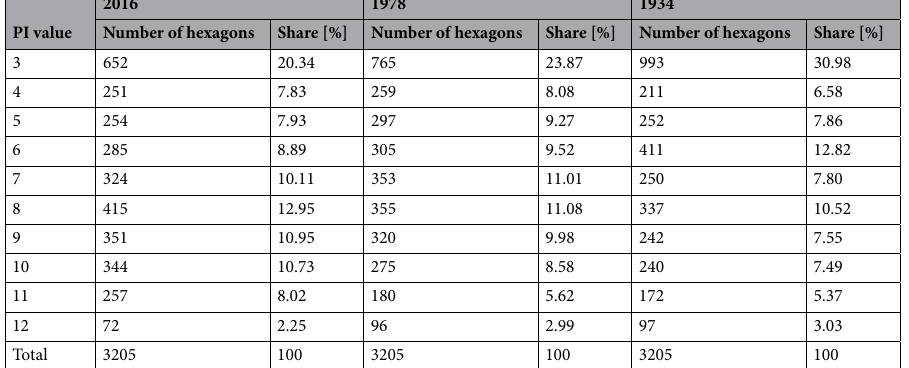
Table 3. Number and share of hexagons within study area.